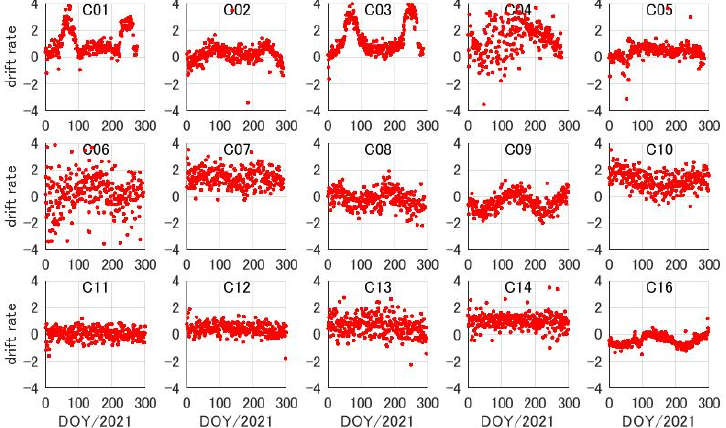
Figure 5. Drift rate series of the BDS-2 onboard clocks from DOY 1 to 300, 2021 (units: 10 − 18 s/s 2 ).